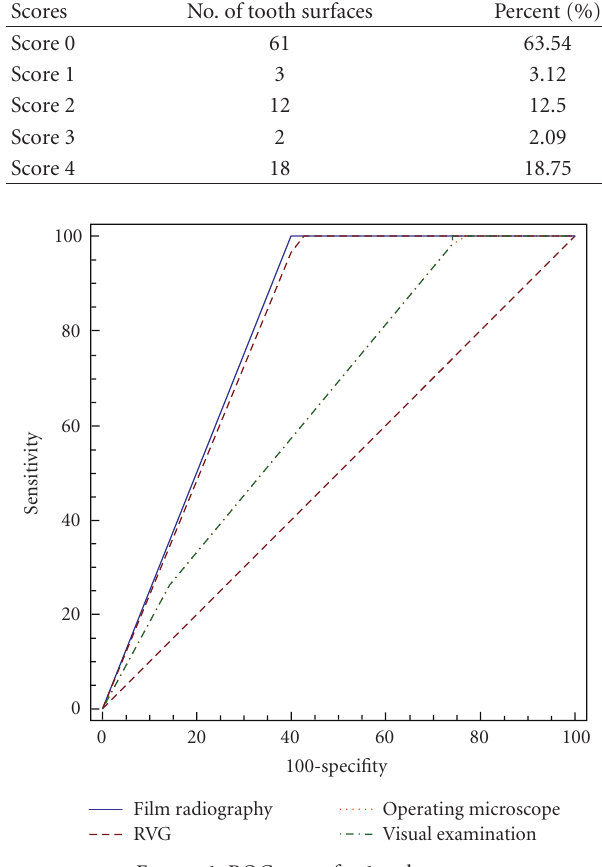
Figure 1: ROC curve for 1st observer.